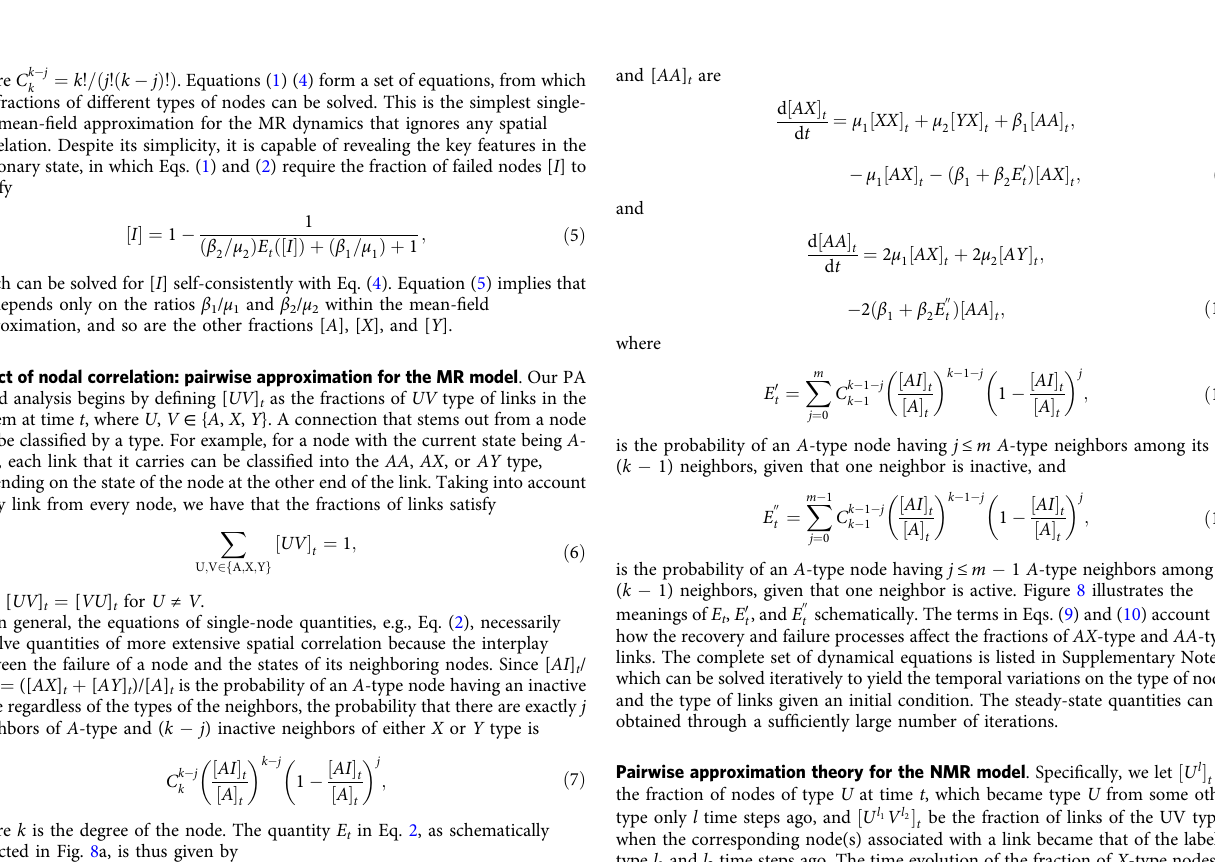
Fig. 8 Schematic diagram for the PA analysis of the MR model. The quantities are E t , E 0 t and E 00 t . The blue (red) color indicates a node in the active (failure) state. Open circles are nodes that may take on A , X , or Y state. In the PA equations, E t is the probability of an A -type node having n ≤ m neighbors of A -type nodes at time t , E 0 A -type node having n ≤ m A -type neighbors among its ( k − 1) neighbors given that one neighbor is t is the probability of an inactive, and E ″ t is the probability of an A -type node having n ≤ m − 1 A -type neighbors among its ( k − 1) neighbors given that one neighbor is